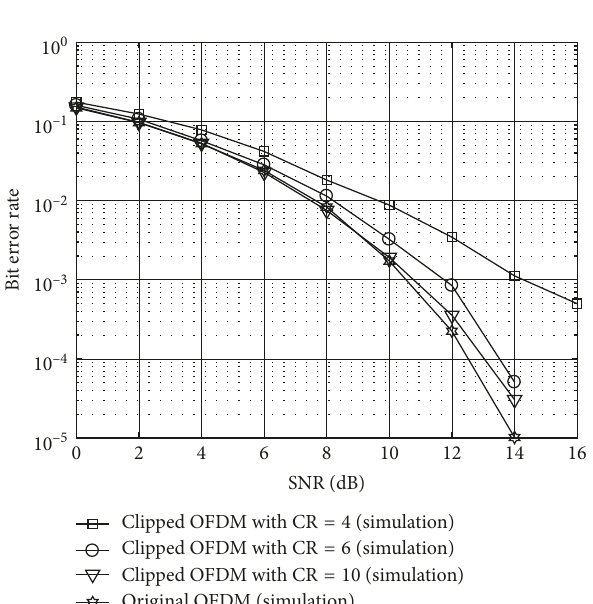
Figure 6: BER performance comparison for different clipped and normalized OFDM without normalization over the fiber channel.